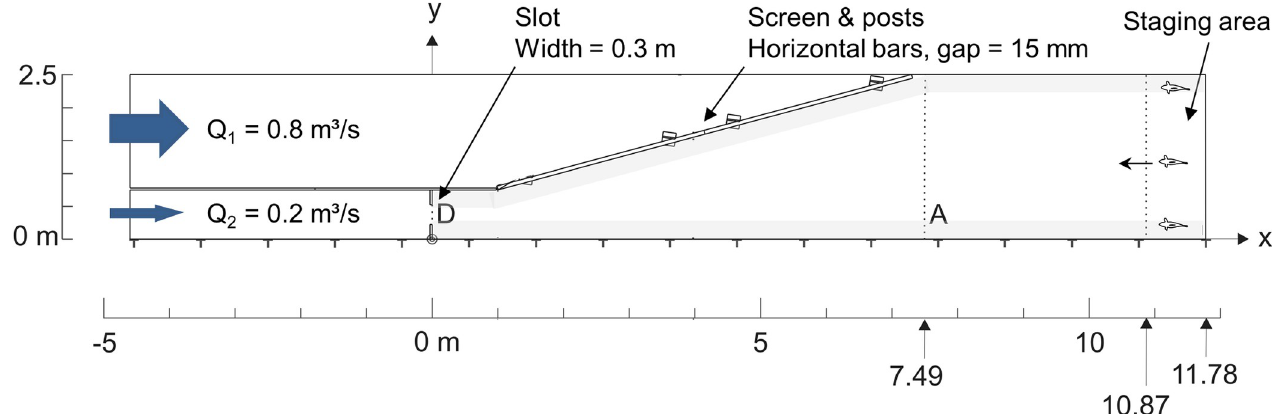
Fig 1. Plan view of flume setup 1. Total length and width = 16.38 m x 2.50 m, water depth = 0.60 m. Flow direction was from left to right. The slot was removed in setup 2 to alter the flow field. Transparent gray areas mark left and right zones (in flow direction) for pattern P1 (defined below, section “Movement patterns”). A and D mark control lines to filter inactive fish and to define pattern P5.